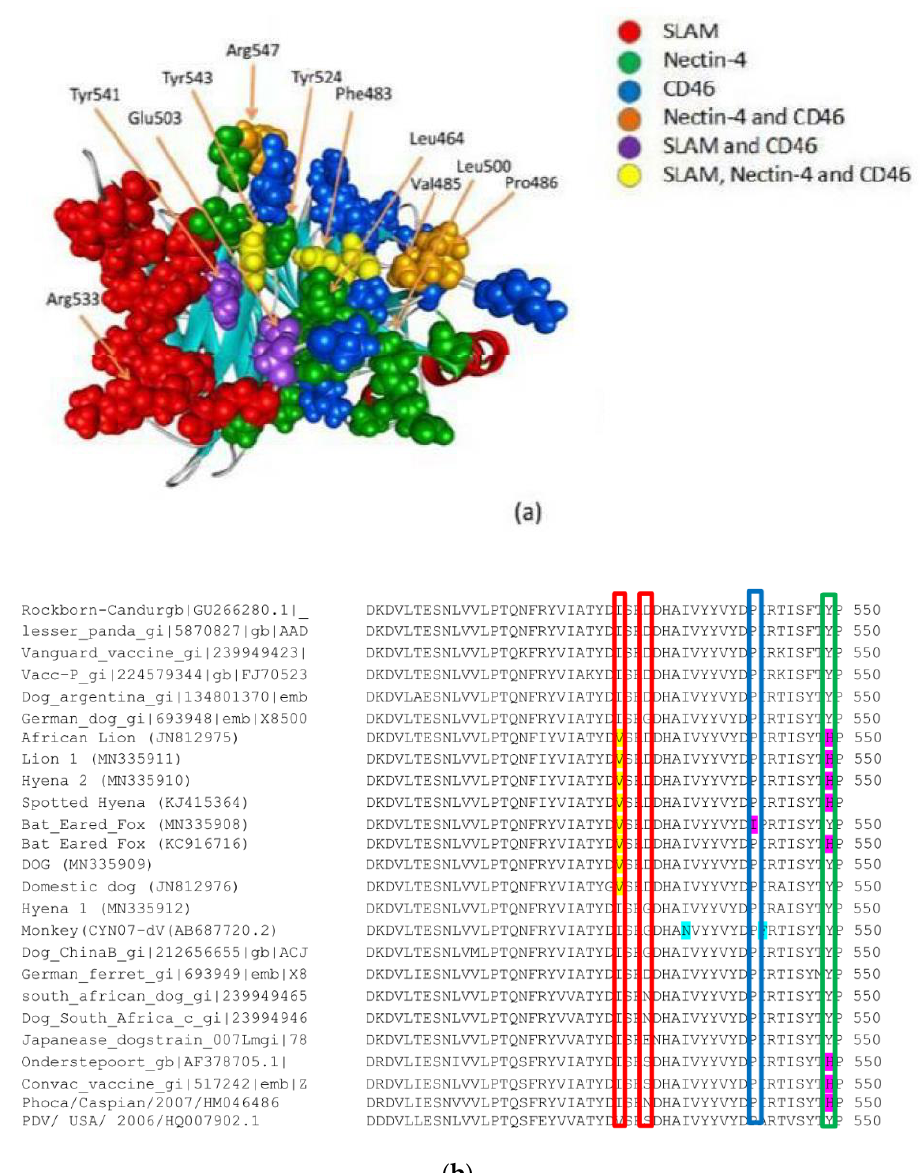
Figure 3. H protein at Receptor binding site. ( a ) Distribution of amino acid residues on morbillivirus haemagglutinin protein, showing significant attraction to the signaling lymphocyte activation molecule (SLAM), nectin-4 and for MeV vaccine strains CD46 (modified from Fenggi et al. [88]. ( b ) Alignment of selected canine distemper virus (CDV) H and phocine distemper (PDV) H amino acid sequences at residues 501 – 550 in the receptor binding site. Boxes indicate: Red, residues critical for SLAM binding; blue, residue critical for Nectin-4 binding; green, site suggested by McCarthy et al. [70] to be associated with spread to non-canine host. Highlighted residues: Yellow, shared by the Serengeti strains; red, consensus sequence; magenta, differences from the consensus; turquoise specific to monkey virus. Substitutions in PDV have not been highlighted.